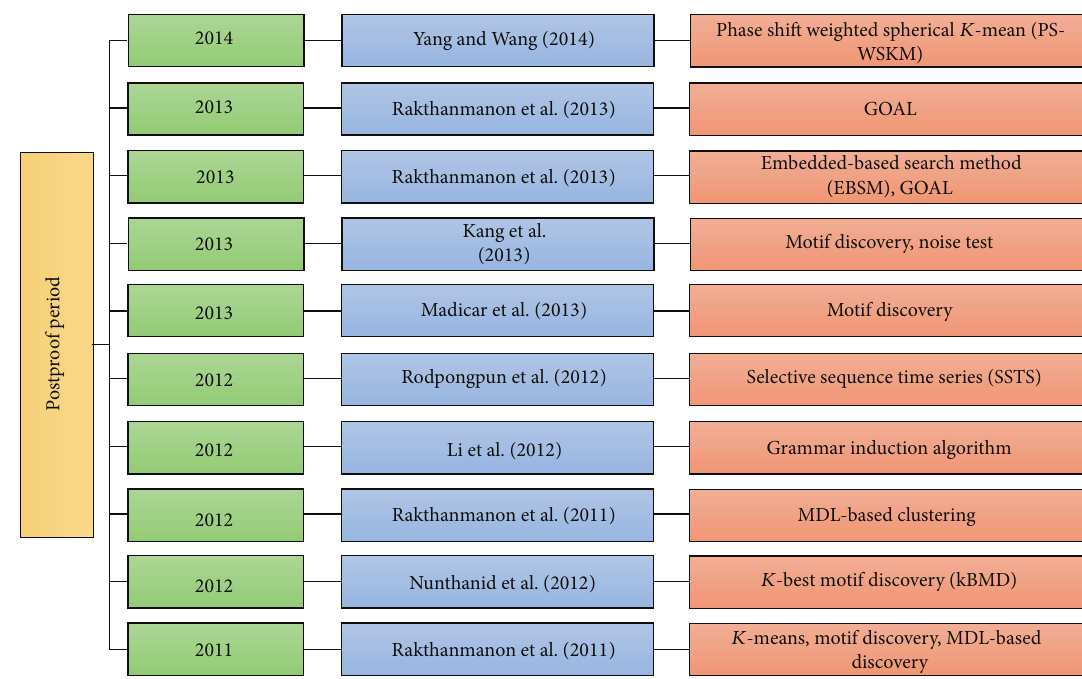
Figure 7: The chronology of methods in postproof